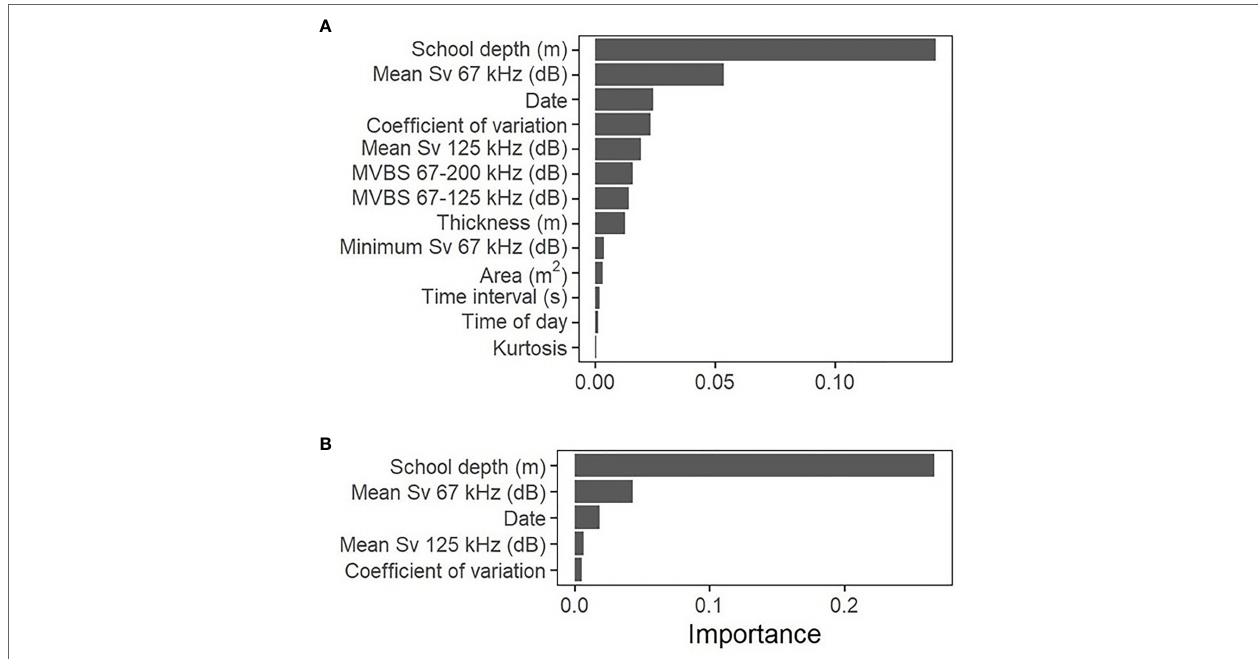
FIGURE 3 | Importance of variables in the random forest model using all non-correlated variables (A) and 5 most important variables